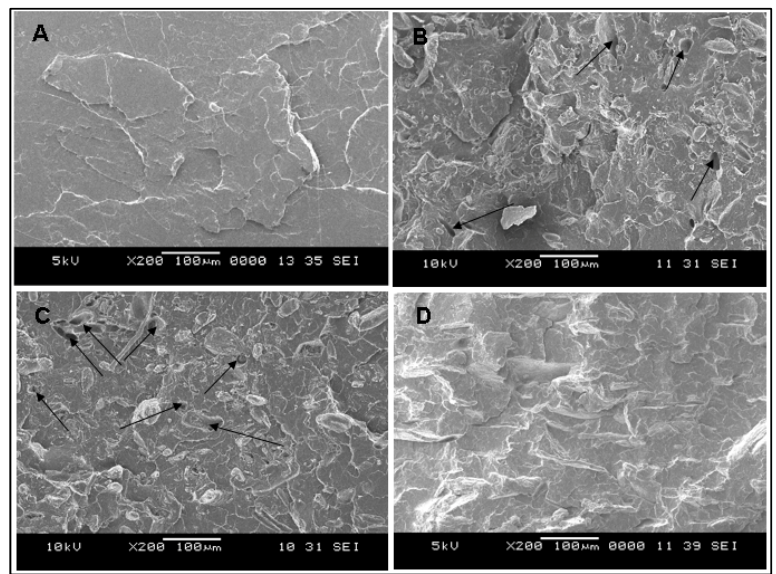
Figure 6. SEM micrographs of PLA/chitosan biocomposites, ( A ) neat PLA, ( B ) unmodified biocomposite (20 php), ( C ) unmodified biocomposite (40 php), ( D ) modified biocomposite (20 php). The arrows indicate the fiber pulled out traces.